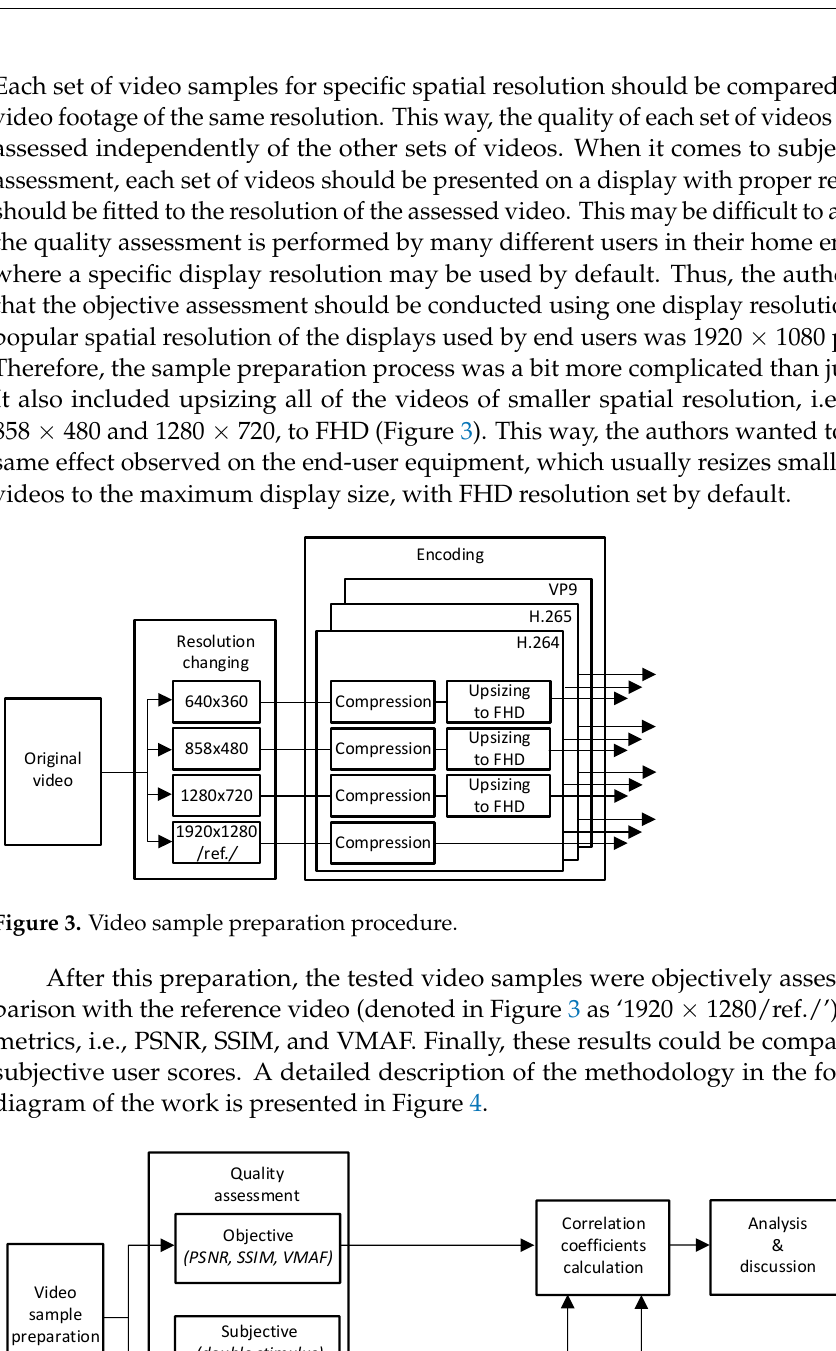
Figure 2. Video quality assessment using double stimulus method.